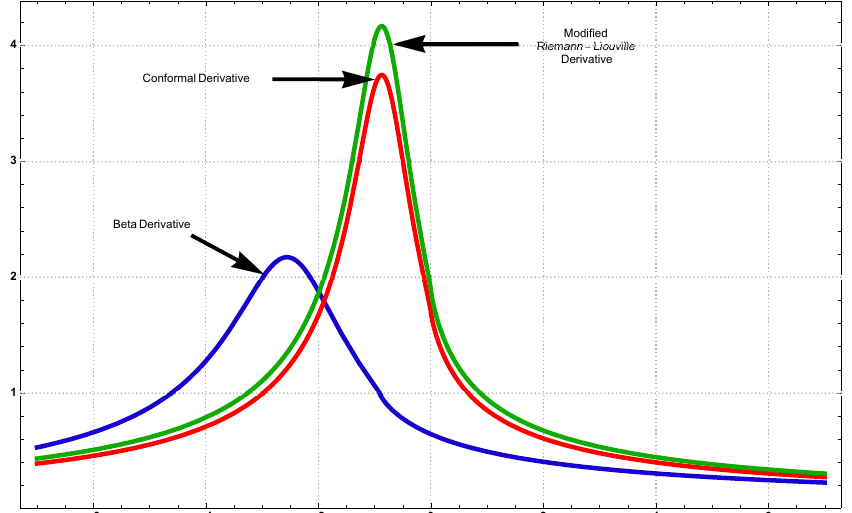
Figure 16. Comparative investigation of the soliton solution | L 31 ( t , x ) | via the modified Riemann– Liouville, conformable and beta derivatives for the fix value of fractional order β = 0.85 defined by these fractional